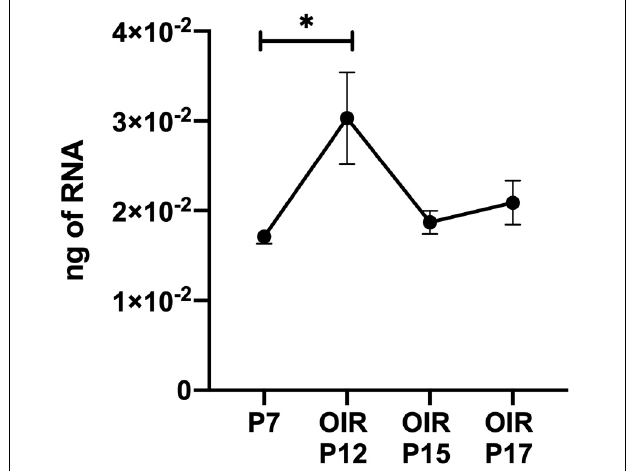
FIGURE 4 | Thrombospondin-1 expression increases during hyperoxia. At P7, C57BL/6j mice were subjected to oxygen-induced ischemic retinopathy (OIR). RNA was extracted from retinas at the noted times and TSP1 was analyzed by qPCR as noted in materials and methods. Please note TSP1 expression increased with hyperoxia (P12). ∗ P <